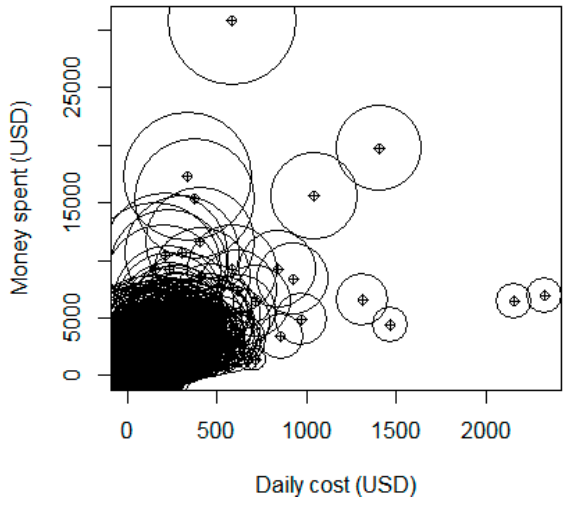
Figure 2. Daily total expenses in USD and daily cost in hospital.